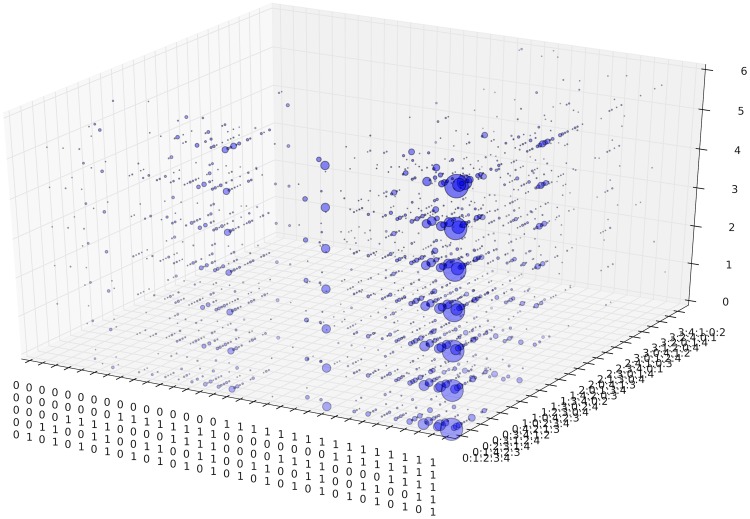
Capacity at each state and each time step in the SA Rich, represented by bubbles.